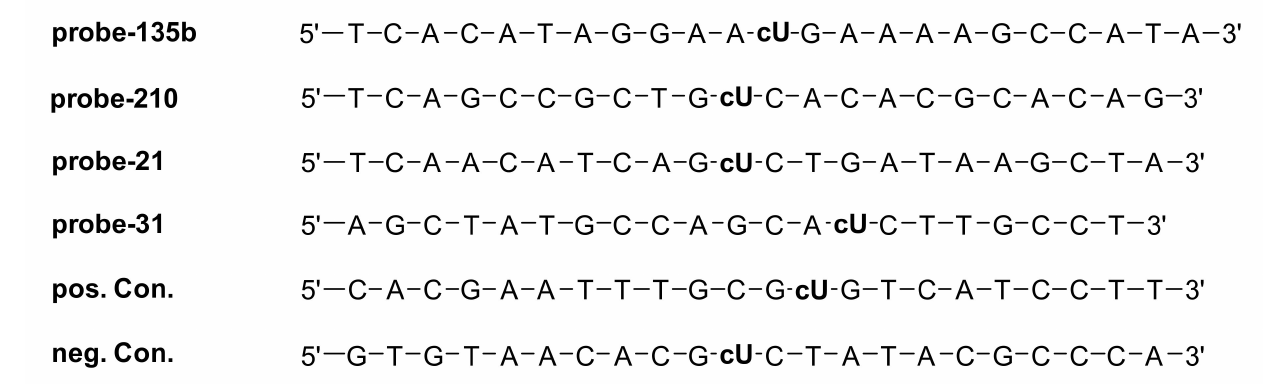
Figure 7. DNA sequences of the synthesised miRNA probes; cU = 2 (cid:48) - O -propargyl-uridine was modified with Cy5 (first set of probes) and AF488 (second set of